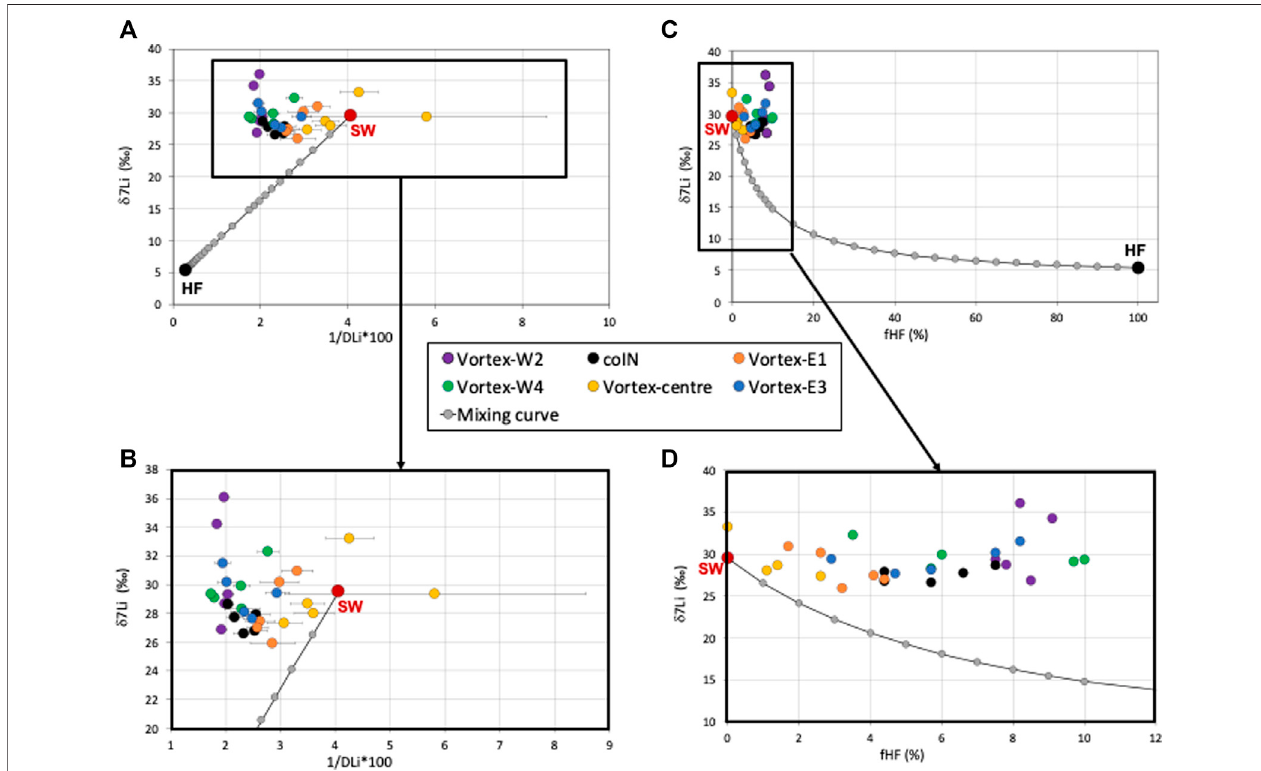
FIGURE 4 | Variations of (A, B) δ 7 Li values as a function of 1/DLi*100 for the six CTD casts, and (C, D) δ 7 Li values as a function of hydrothermal fl uid contribution calculated considering a conservative DLi behavior (fHF%). For the four plots, a conservative mixing trend between seawater and hydrothermal fl uid end-members is reported as gray dots. Seawater (SW, red dot), and hydrothermal fl uid (HF, black dot) end-members are